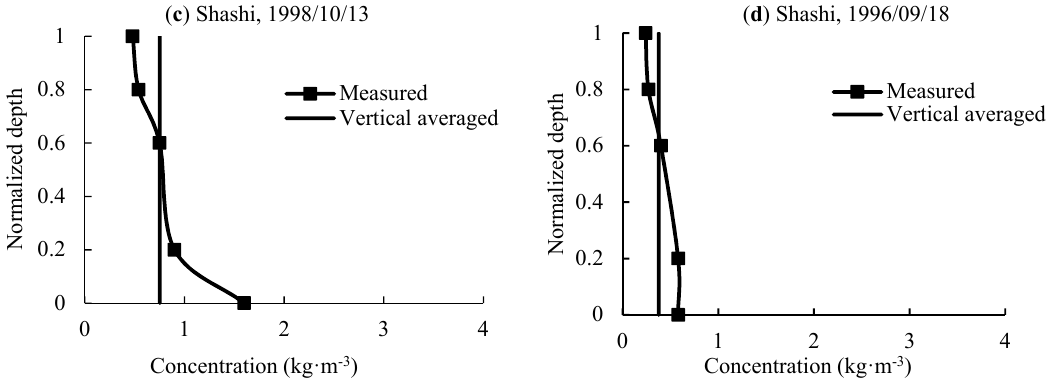
Figure 3. Typical measured vertical profiles of SSC and vertical averaged concentration in the JJRR, measured at Shashi hydrological station before ( c , d ) and after 2010 ( a , b ).